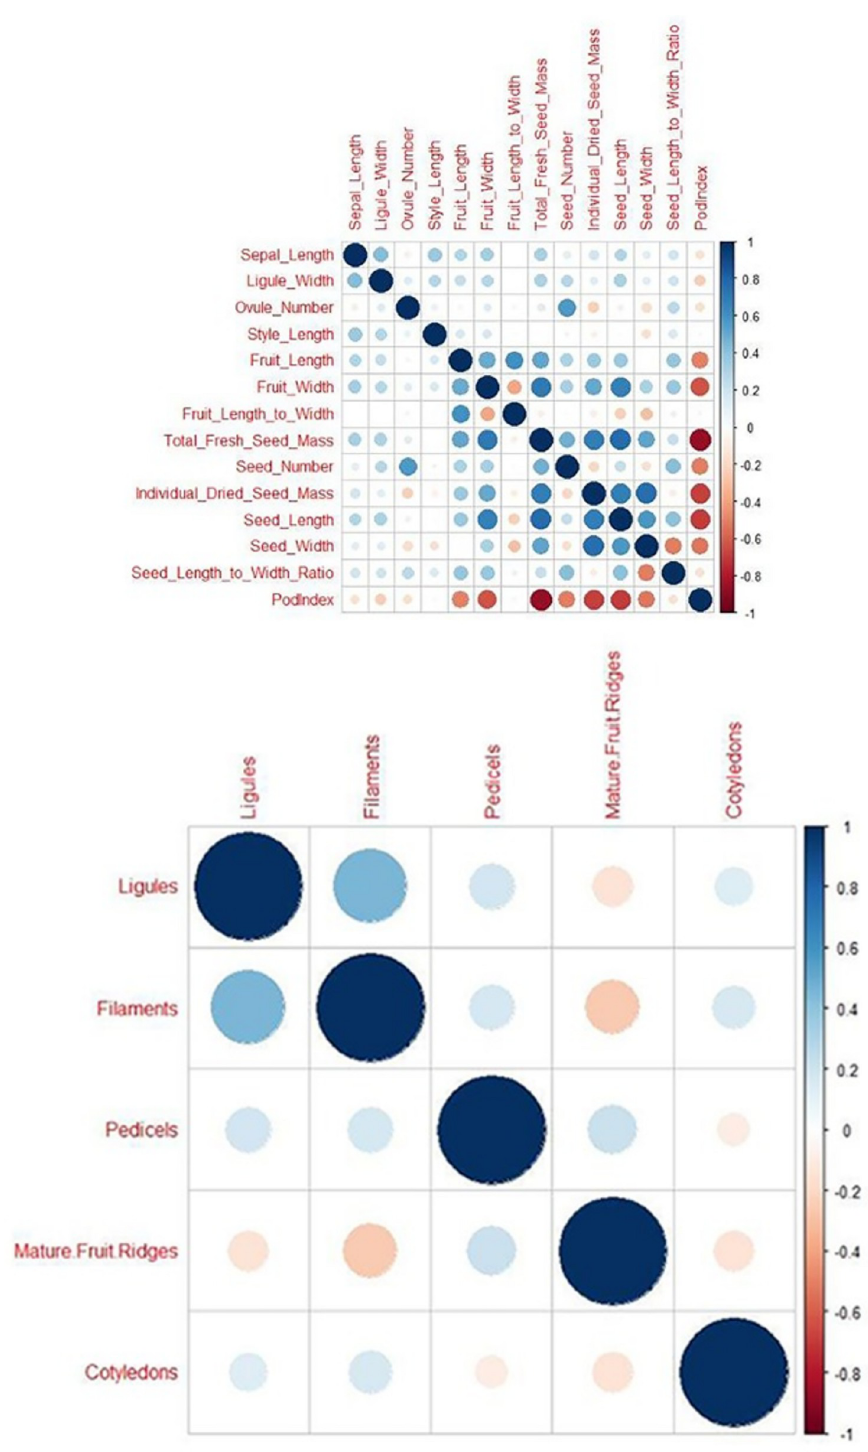
Fig 2. Correlograms showing Pearson correlations for quantitative traits and Spearman correlations for anthocyanin intensity in various plant organs. Positive correlations are displayed as blue circles and negative correlations as orange circles. The sizes of the circles are proportional to the correlation coefficients. The plant organs for which anthocyanin intensity was measured were the flower ligule, filament and pedicel, and mature fruit ridges and seed